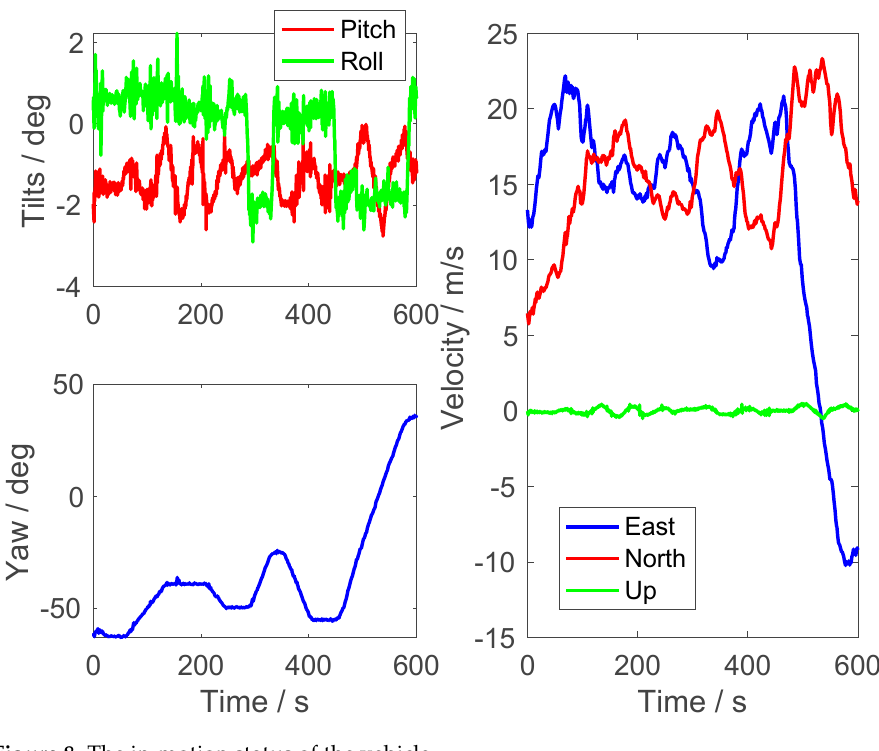
Figure 8. The in-motion status of the vehicle.